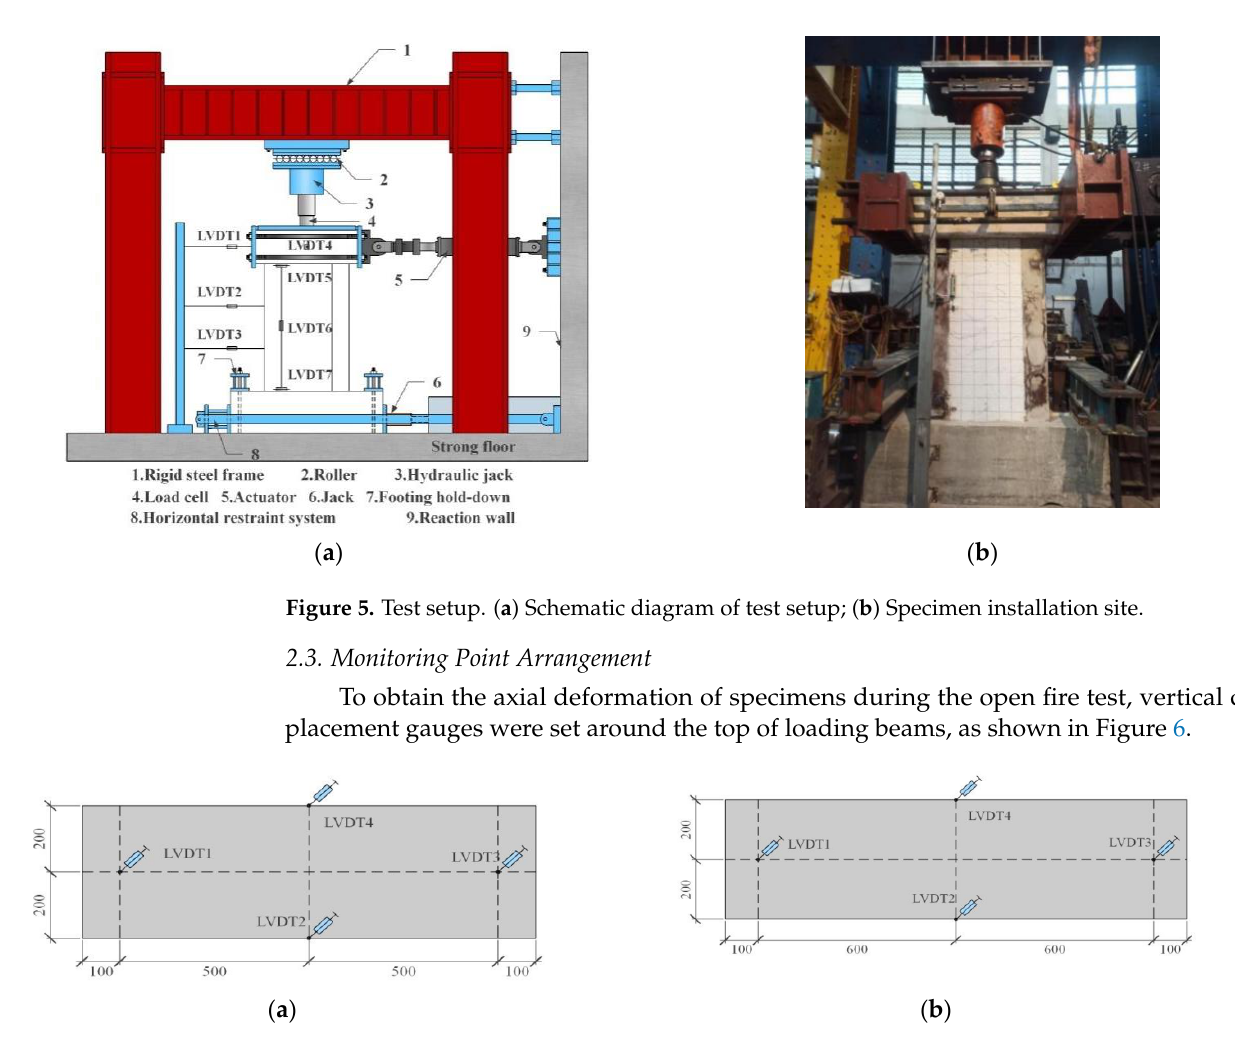
Figure 4. Fire protection treatment of specimen.